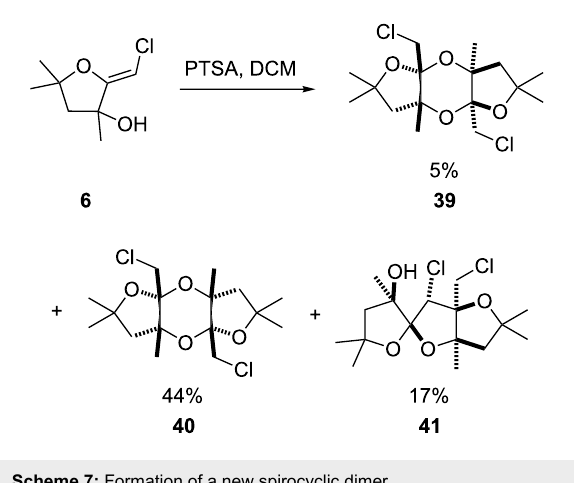
Scheme 7: Formation of a new spirocyclic dimer.